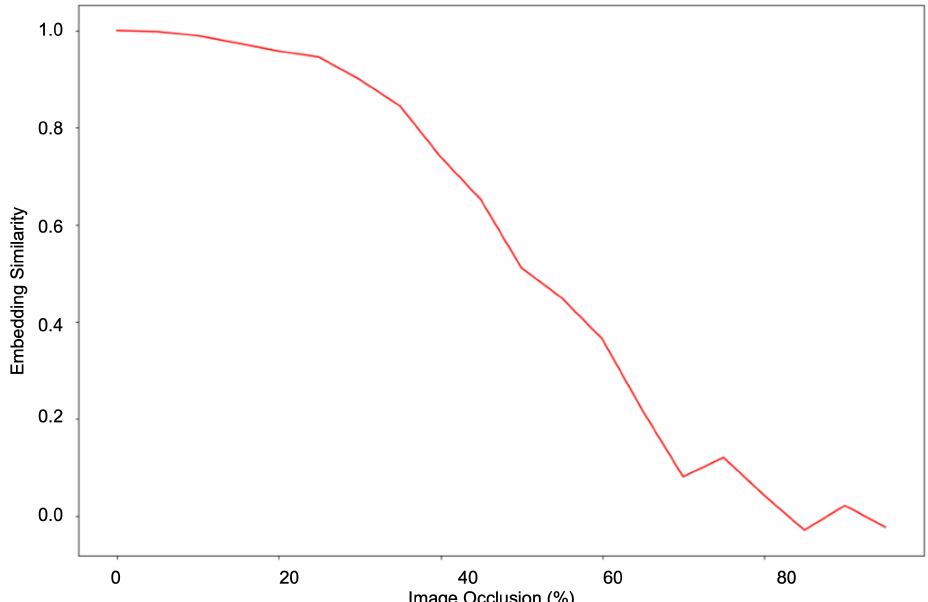
Figure 9. Testing gradual vertical occlusion robustness. Note the cosine similarity falls off far sooner than the horizontal occlusion